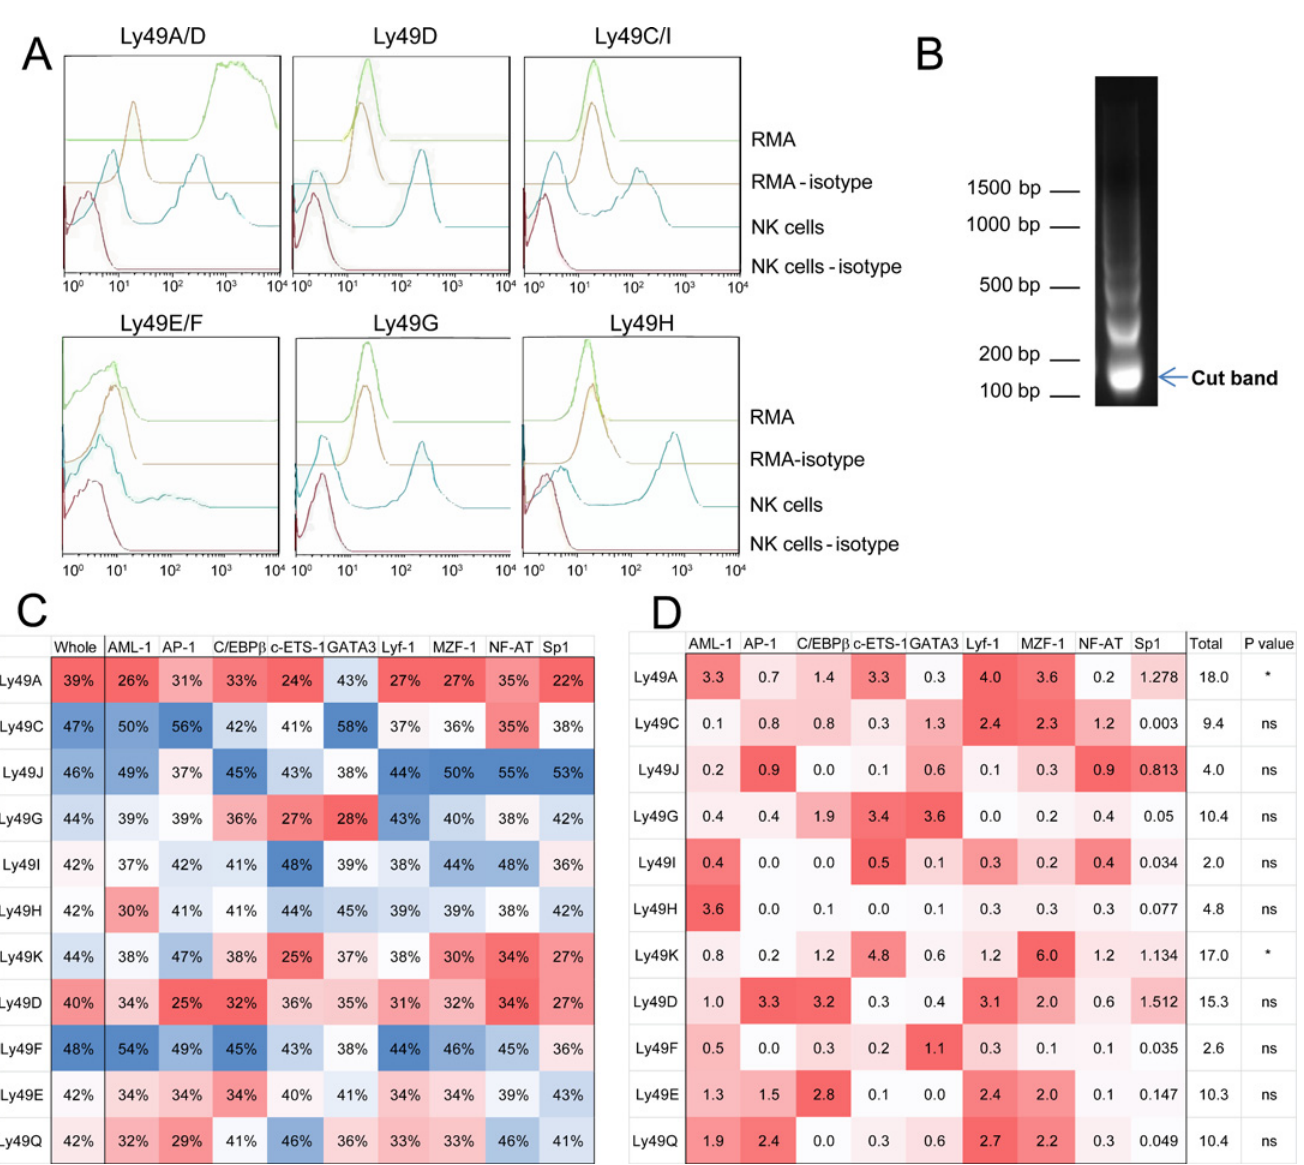
nucleosome status from this expected result. Only two Ly49 promoters were significantly diver- gent in nucleosome occupancy at the tested TF binding sites: the pseudogene Ly49K, and the expressed Ly49A (Fig 4D). All other Ly49 genes are not expressed in RMA, and were not found